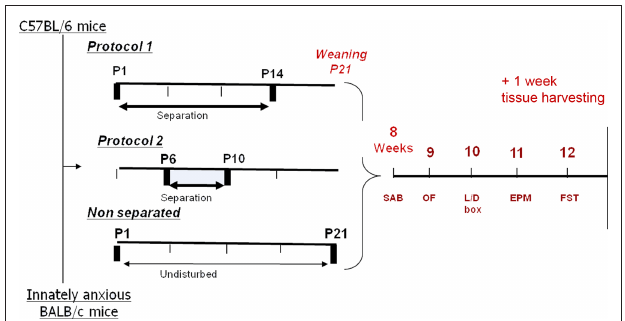
Figure 1 | representation of the experimental design of early-life stress procedure. C57BL/6 and BALB/c mice pups were separated from their mother for a long (protocol 1, P1–14) or short (protocol 2, P6–10) period, while control animals were left undisturbed, except for routine cages changes (“animal-facility-reared, AFR”); all pups then remained undisturbed until weaning and underwent a battery of behavioral testing for cognition, anxiety and depression-like behaviors at adulthood (8 weeks old). Animals were sacrificed at 13 weeks old. Mice weight was monitored from weaning on till the end of